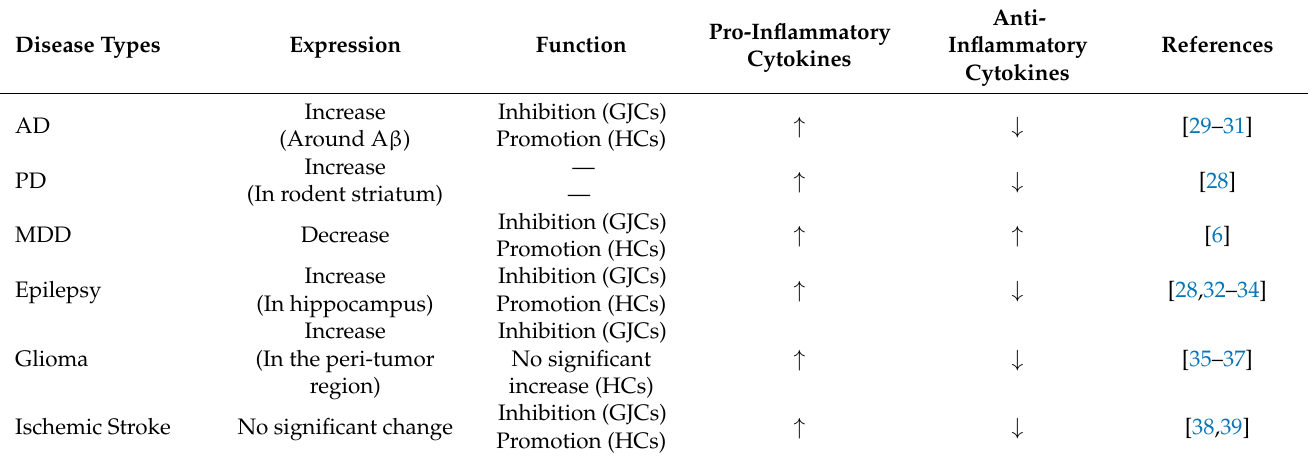
Table 1. Changes in Cx43 of astrocytes, and inflammatory signatures in different neuropsychiatric diseases.